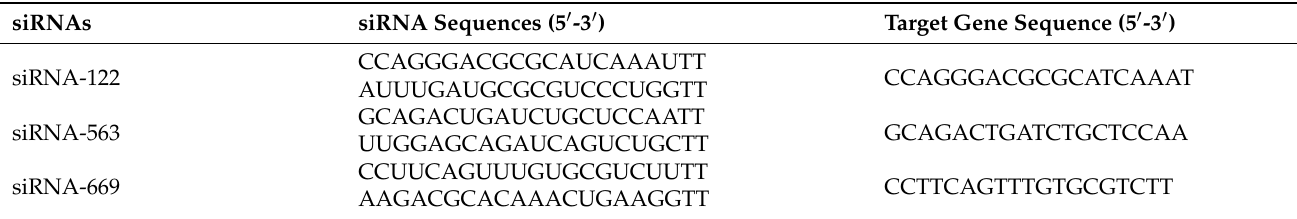
Table 1. Sequences for the siRNAs targeting the CDKN1A gene. siRNA Sequences (5 (cid:48) -3 (cid:48)